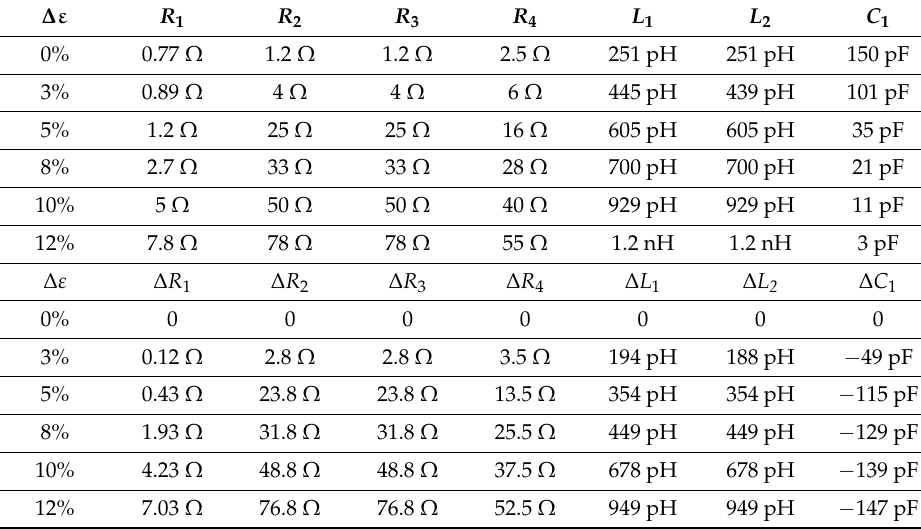
Figure 5. The calculated S-parameters under various strains: ( a ) S11 spectra; ( b ) S21 spectra. Table 2. The element parameters for fitting.